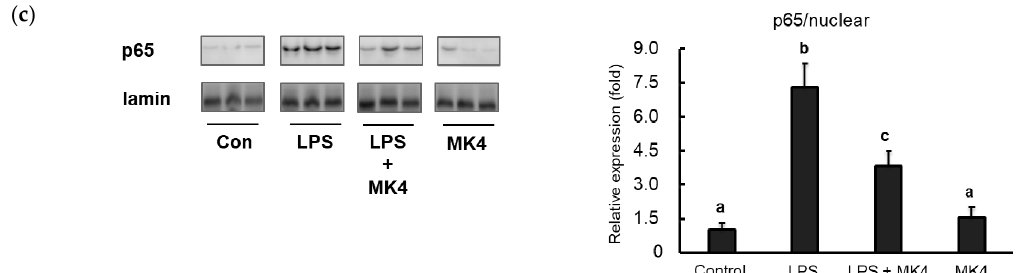
Figure 6. Menaquinone-4 (MK-4) inhibits the LPS-induced nuclear translocation of the NF- κ B p65 subunit. ( a ) MG6 cells were administered MK-4 (10 µM) for 24 h and then treated with lipopolysaccharide (1 ng/mL) for 30 min. The cells were fixed and labeled with anti-p65 (red) antibodies. Next, the cells were visualized under a fluorescence microscope. Nuclei were stained with Hoechst 33258 (1 µg/mL) (blue). Scale bars, 20 µm. ( b – c ) After MK-4 (10 µM) treatment and LPS (1 ng/mL) administration for 30 min, MG6 cells were fractionated into cytoplasmic and nuclear components. NF- κ B was then measured by western blotting in the cytoplasmic ( b ) and nuclear ( c ) fractions. Data are presented as the mean ± SE ( n = 3), normalized to ɑ tubulin (cytoplasmic) or lamin (nuclear) levels, and expressed as the fold-change relative to control cell values. The values with different letters a–c were significantly different at p < 0.05.